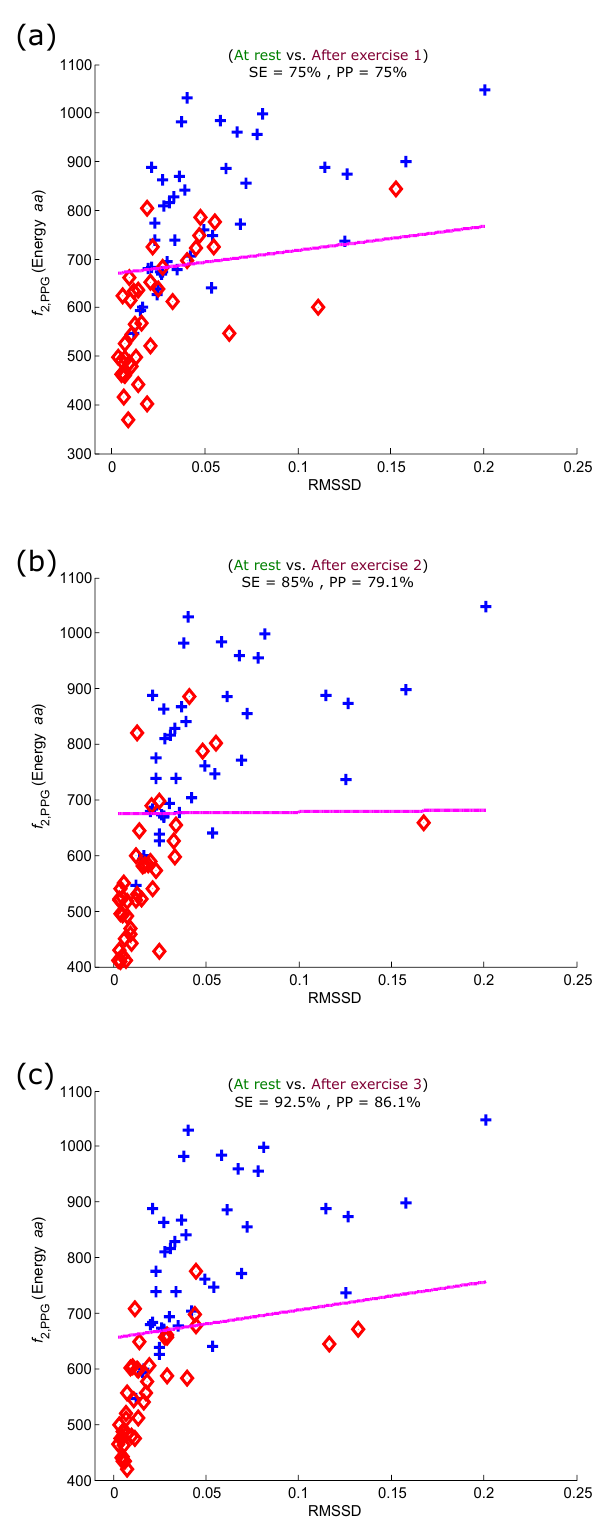
Figure 8. Linear classification of PPG signals measured before and after the simulated heat stress induction based on the energy of the aa area of the PPG signal and RMSSD. ( a ) At rest vs. after exercise 1; ( b ) at rest vs. after exercise 2; ( c ) at rest vs. after exercise 3. Here, RMSSD stands for square root of the mean of the squares of the successive aa (heartbeats) intervals; SE stands for sensitivity; and PP stands for positive predictivity. The plus signs refer to subjects measured at rest, while the diamond signs refer to subjects measured after the simulated heat stress